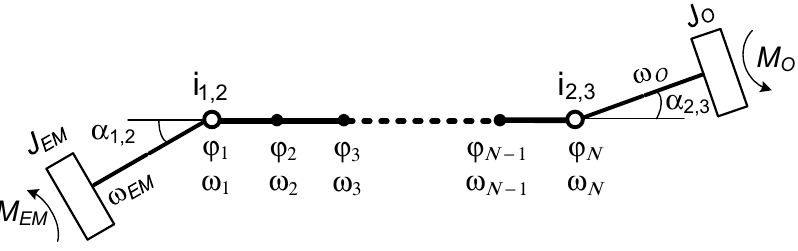
Figure 1. Motion transmission of a three-shaft drive train.